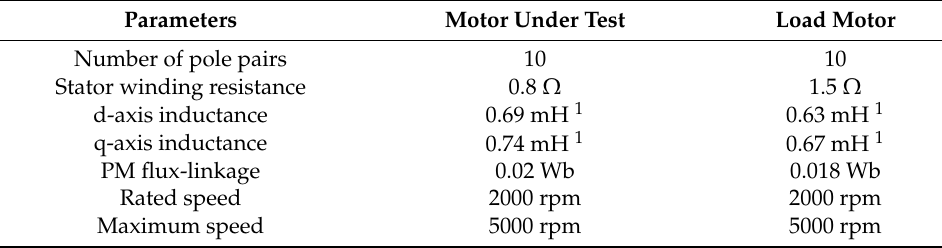
Figure 14. Experiment platform. Table 1. Parameters of motor under test and load motor.